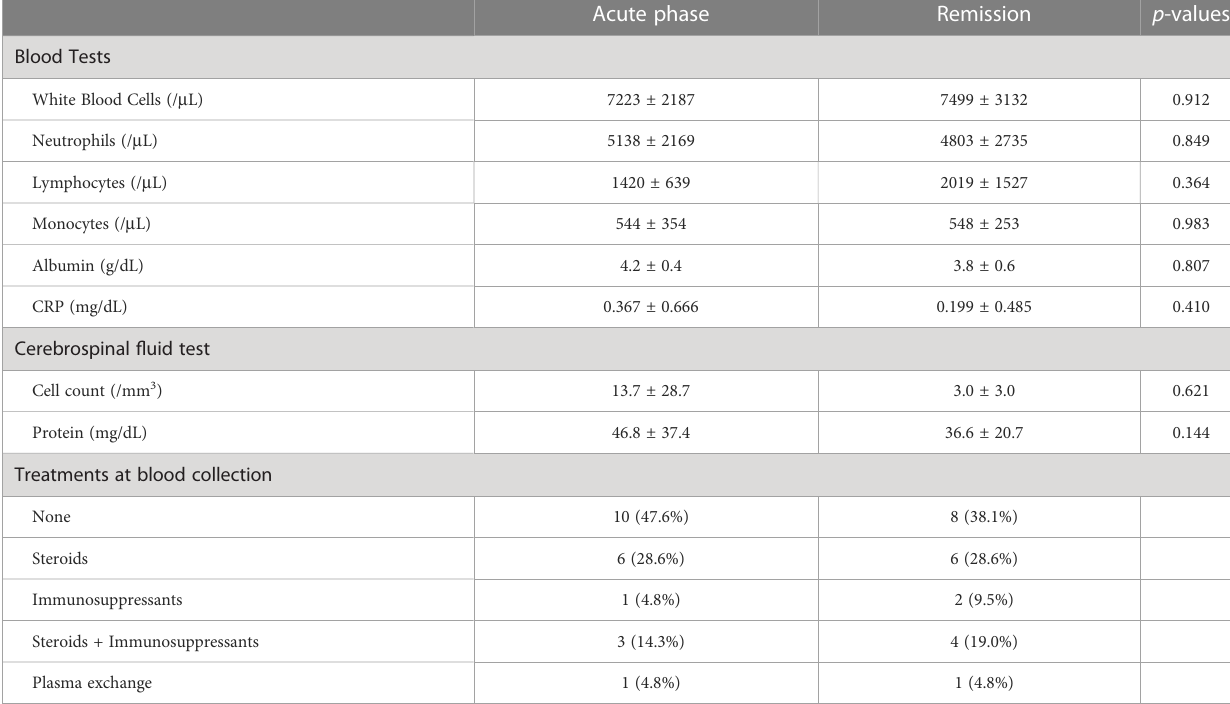
TABLE 2 Laboratory data and treatments of the patients with NMOSD.